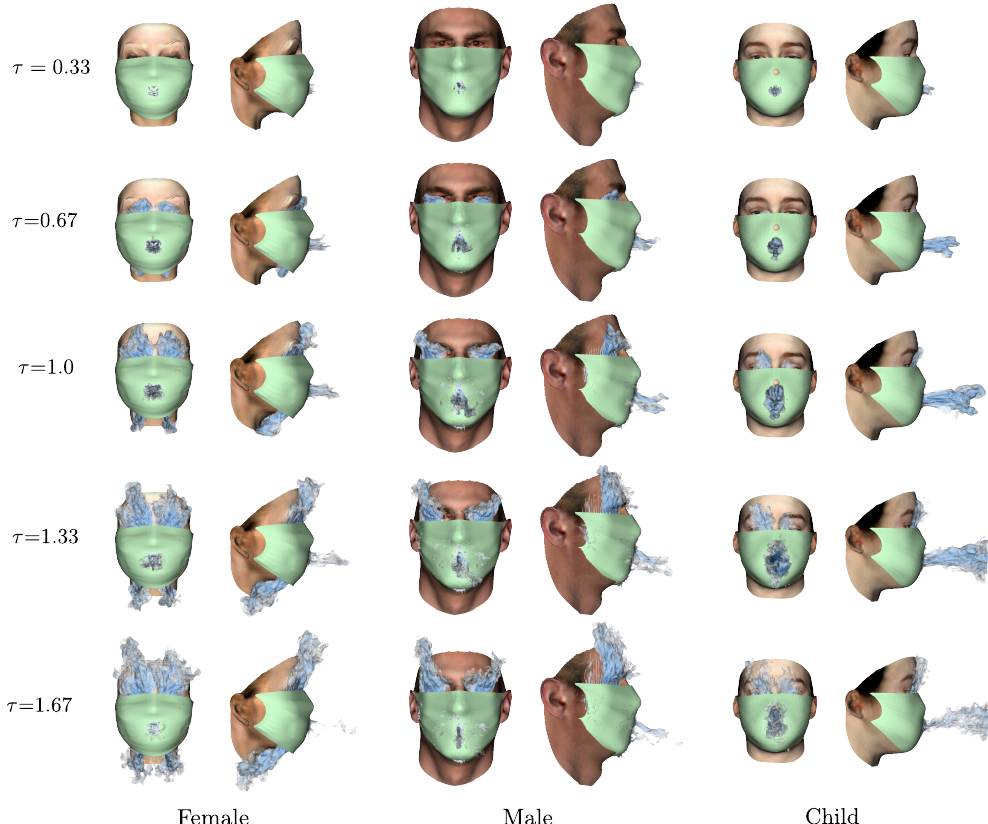
Figure 3. Time evolution of the flow during a coughing episode for a female ( left ), male ( center ) and child ( right ) face with a porous masks ( c k = 100 Pa · s/m). Front and side views of the iso-surface contours of velocity magnitude over